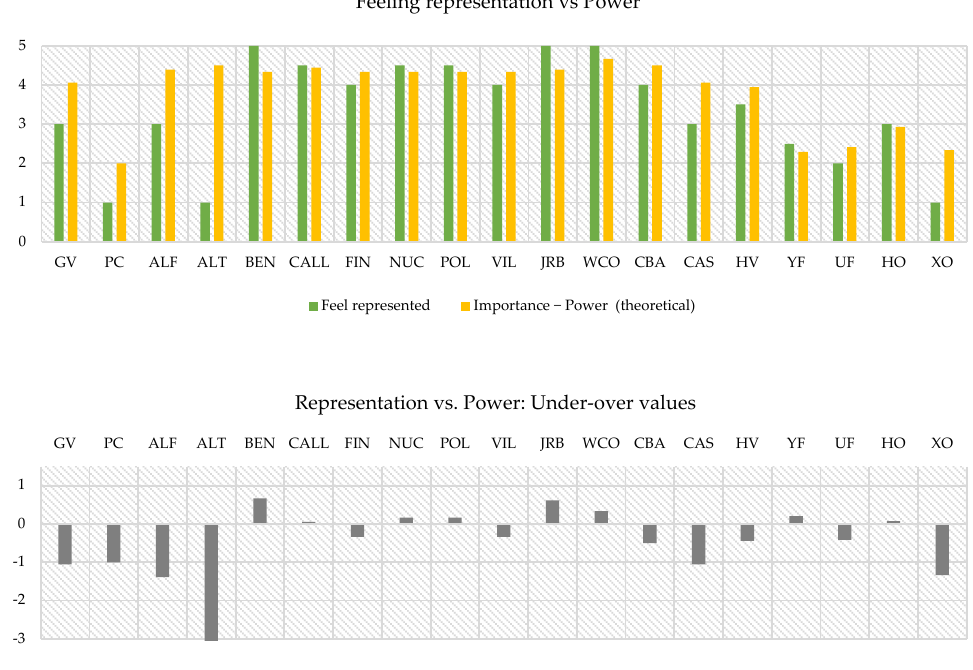
Figure 8. Representation vs. power ( upper figure ), including under-over values ( lower figure ). Legend: 0 (do not know/no answer), 1 (not represented at all), 2 (not represented enough), 3 (partially represented), 4 (quite represented), and 5 (absolutely represented). Note: government officials (GV, PC, ALF, ALT, BEN, CALL, FIN, NUC, POL and VIL); water managers (JRB and WCO); agricultural sector (CBA, CAS, HV, YF, UF); tourism sector (HO); environmental sector (XO).